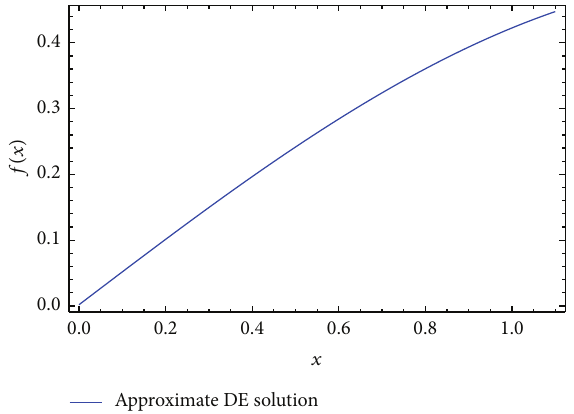
Figure 8: Approximate solution for 𝑦 󸀠󸀠 −0.05(1−𝑦 2 )𝑦 󸀠 +𝑦 = 0 with 𝑦(0) = 0 and 𝑦 󸀠 (0) = 0.5 .